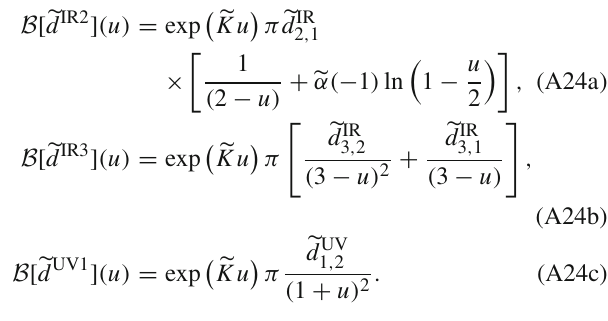
Table 7 The (MS) coefficients (cid:8) r n and r n (with κ = 1) of the FOPT expansion in powers of a (σ m ) for the FESR r (σ m ) = a ( 2 , 1 ) (σ m ) ( D = 0 ) [ = r τ (σ m ) ( D = 0 ) ], where the considered renormalon-motivated Adler